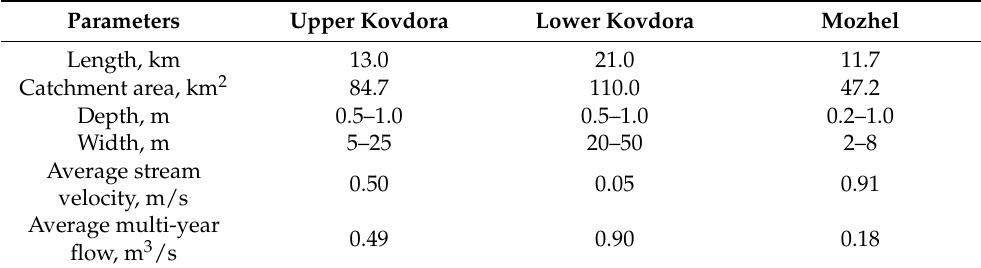
Table 1. Hydrological characteristics of the Upper Kovdora, Lower Kovdora, and Mozhel rivers.